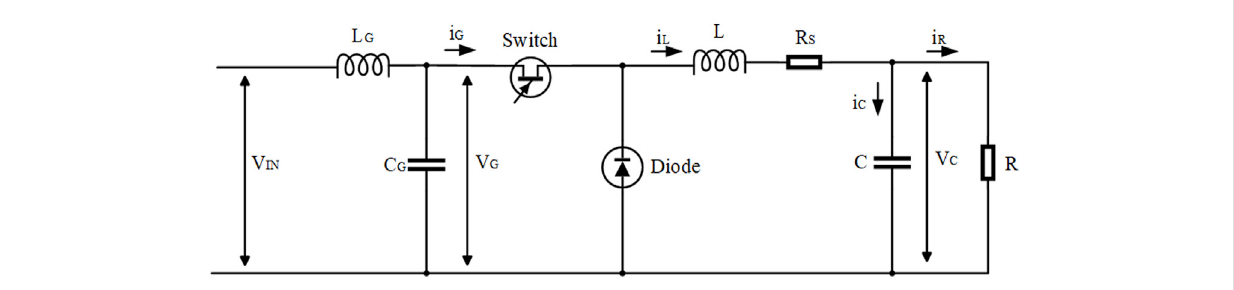
Topology of buck